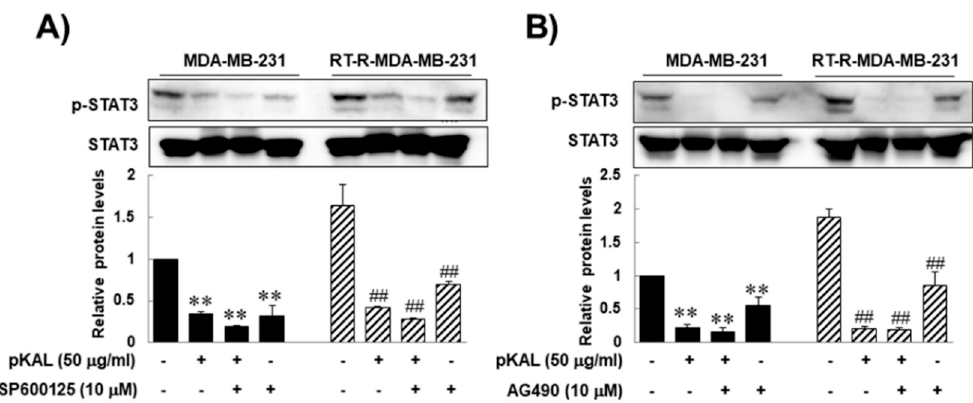
Figure 4. The effects of the JNK or JAK2 inhibitor alone or in combination with pKAL on the STAT3 phosphorylation of both parental and RT-R-MDA-MB-231 cells. The cells were treated with the indicated agent alone or in combination with pKAL for 24 h. The expressions of p-STAT3 or STAT3 were measured by Western blot analysis and densitometry, and the values are expressed as the means ± SEM from three independent determinations (** p < 0.01 vs. control for parental MDA-MB-231 cells, and ## p < 0.01 vs. control for RT-R-MDA-MB-231 cells).